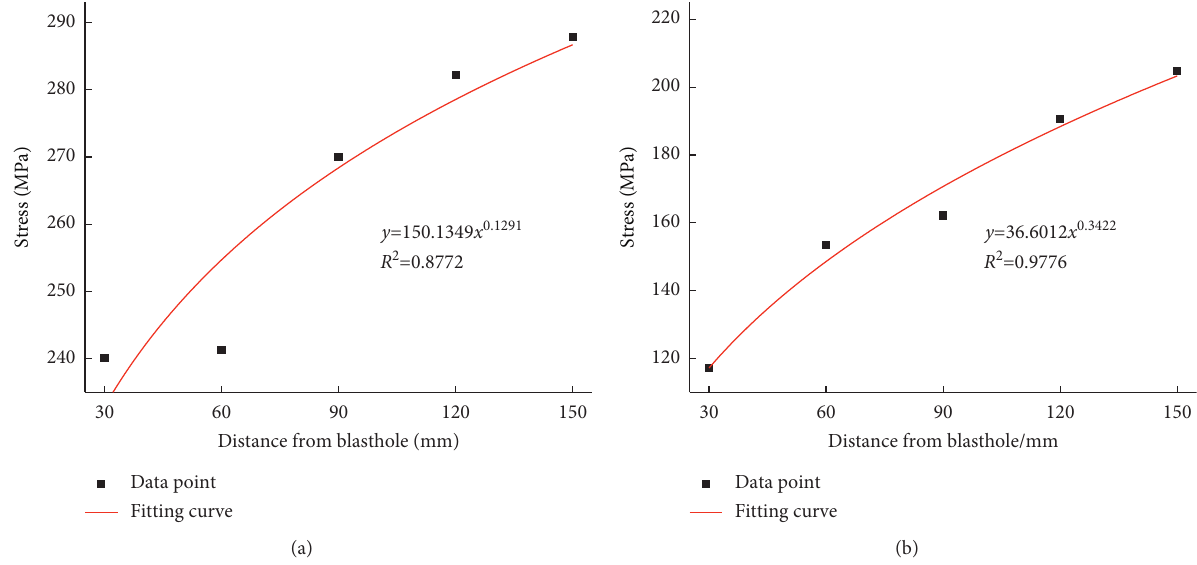
Figure 6: Fitting curves of yield strength and distance of specimen. (a) Vertical cutting direction. (b) Slitting direction.